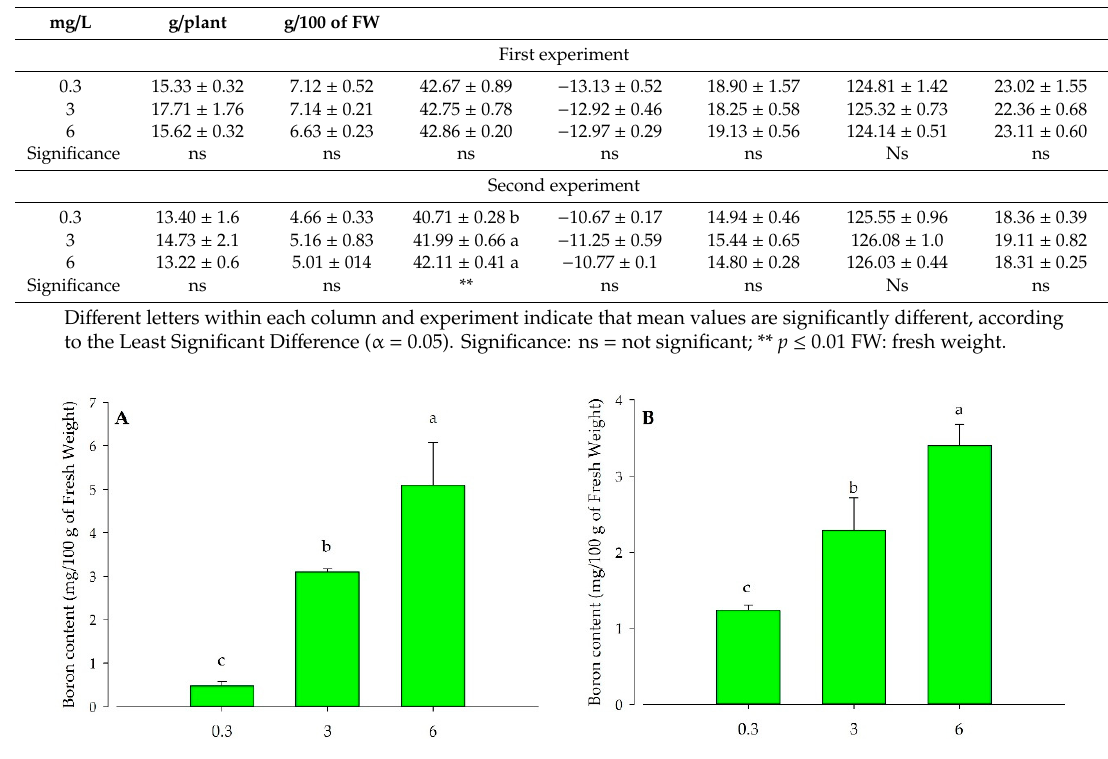
Figure 2. Boron content in edible parts of wild ( A : firsxperiment) and commercial ( B : second experiment) purslane, as affected by different boron levels in the nutrient solution, control (0.3 mg/L), and two levels of B biofortification (3 and 6 mg/L). Different letters indicate that mean values are significantly different, according to the Least Significant Difference ( α = 0.05).